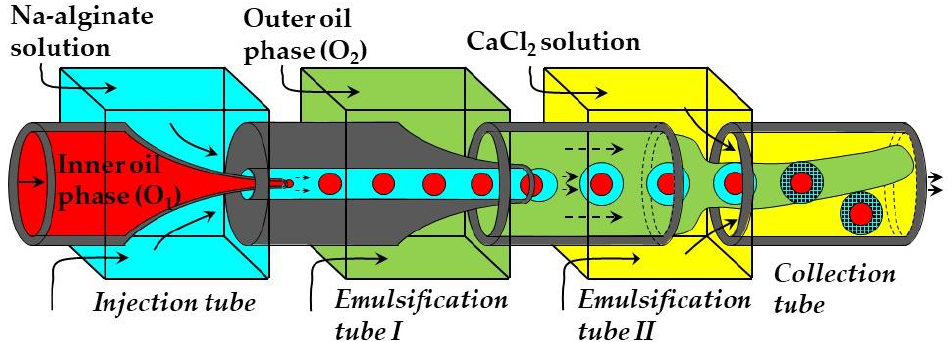
Figure 27. Co-flow glass capillary device for fabrication of oil-core alginate-shell microgels via on- chip gelation of shell solution within O 1 /W/O 2 emulsion droplets. The droplets sink to the bottom of the collection tube due to density difference between the formed beads and the oil phase [114]. Core−shell microgels with an oil core and a gellan shell were fabricated using O/W/O double emulsion templates. On-chip crosslinking of gellan polymer chains in the middle phase was induced by calcium acetate dissolved in the outer oil phase, Figure 28 [115].